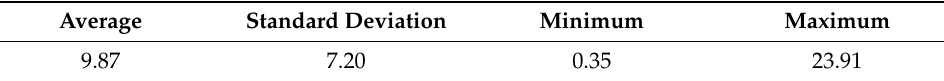
Table 7. Summary of the length estimation errors